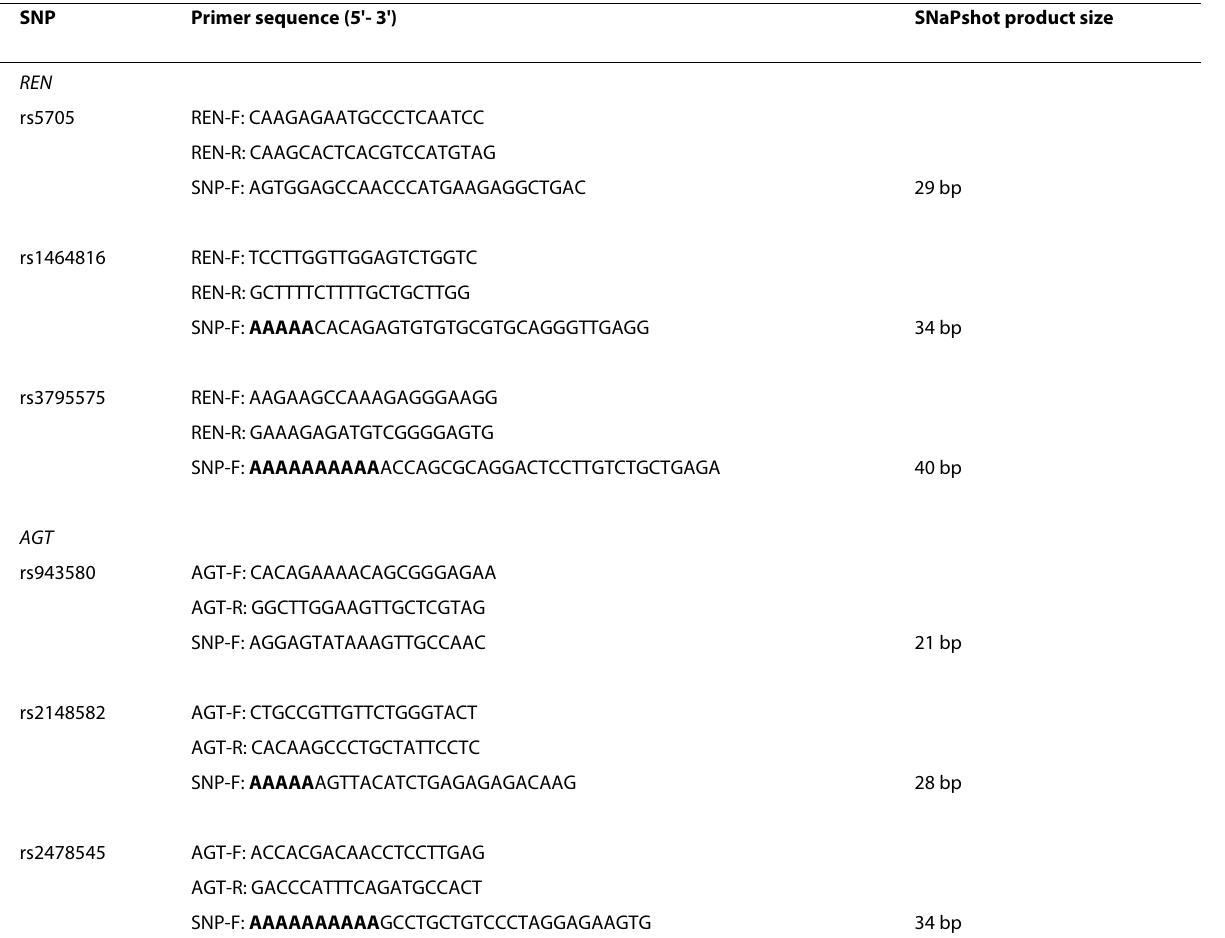
Table 1: PCR primers and SNP extension primers SNP Primer sequence (5'-